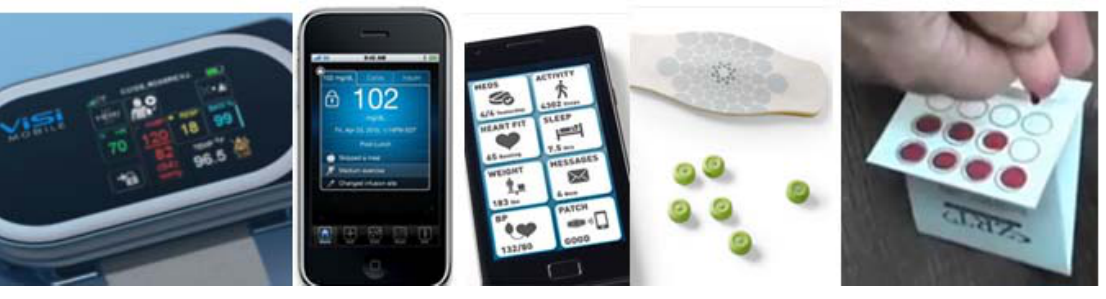
Figure 6. Continuous Monitoring: Sotera’s Visi Mobile, AgaMatrix iBGStar Smartphone-Connected Glucometer, Proteus Digital Medicine Pill Consumption Tracking System, and Next-Generation Dried Blood Spot Testing from ZRT